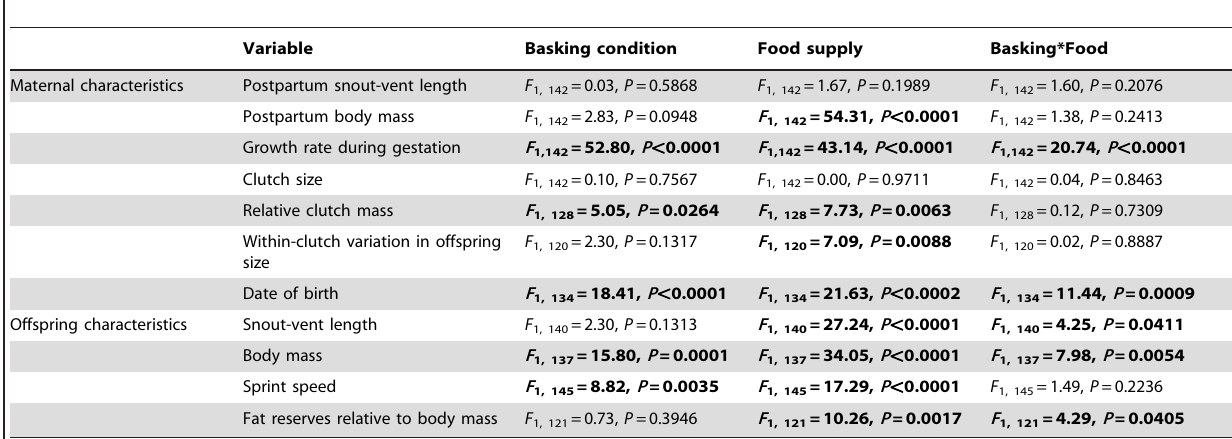
Summary of the results of statistical analyses of the effects of maternal basking and food availability (combinations of extended and restricted basking opportunities and food supply) and their interaction during gestation on female and offspring in Pseudemoia entrecasteauxii . Significant results are indicated in bold. doi:10.1371/journal.pone.0041835.t002 PLoS ONE |